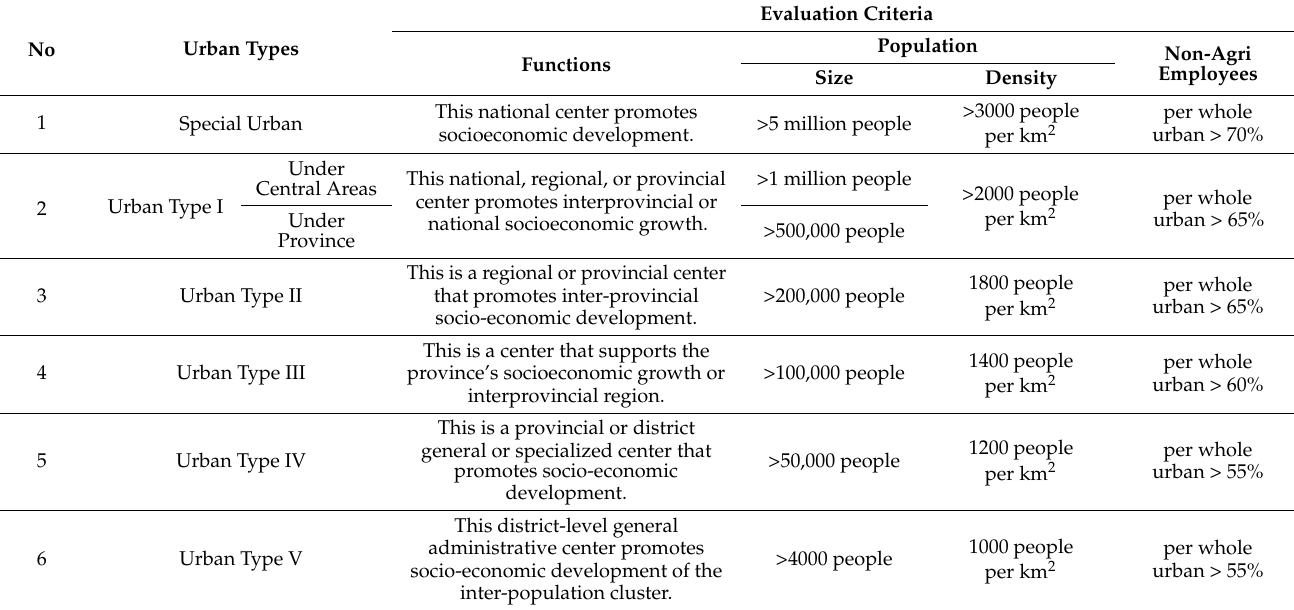
Table 1. Classification of urban areas in